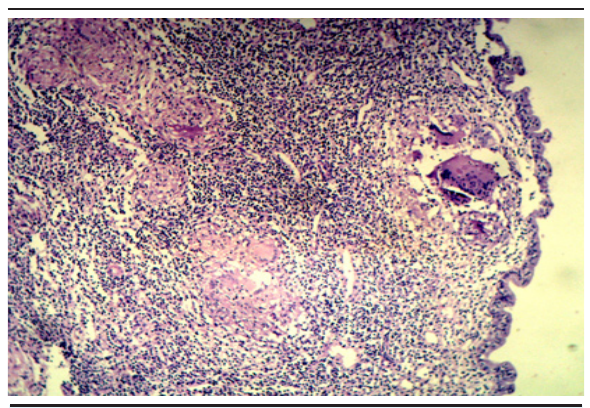
figure 4. Gross photograph showing tuberculous inflammation which presented as Tubo- Ovarian mass. Multiple small nodular lesions were found in fallopian tube and ovary on cut section.